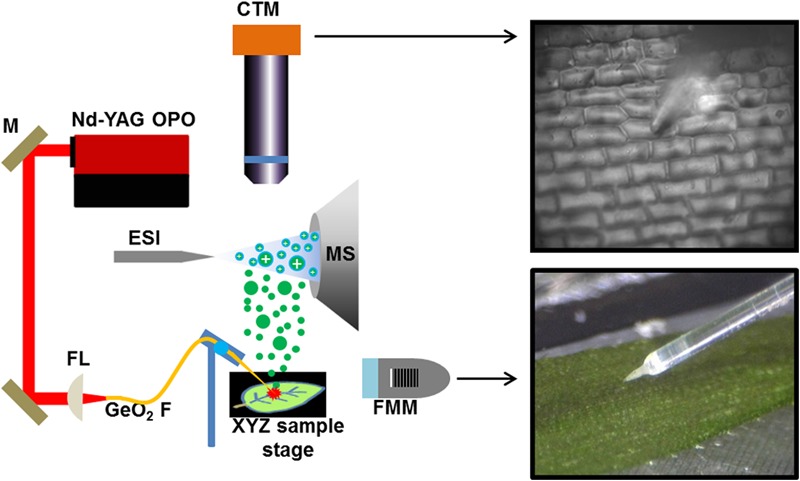
Schematic of f-LAESI setup for single cell analysis. A mid IR laser beam is steered by gold coated mirrors (M) and coupled through a CaF2 focusing lens (FL) into a germanium oxide-based optical fiber (GeO2 F). When the etched fiber tip is brought into close proximity of the cell, an ablation plume of neutrals (green dots) is produced. The expanding plume is intercepted and ionized by an electrospray (blue dots) that is on axis with the inlet orifice of the mass spectrometer. Both the optical fiber and the sample are mounted on XYZ stages for fine adjustments. A fiber monitoring microscope (FMM) is positioned under 20° elevation angle to monitor the distance between the fiber tip and the sample surface. For cell selection, a cell targeting microscope (CTM) is positioned under right angle to the sample surface.